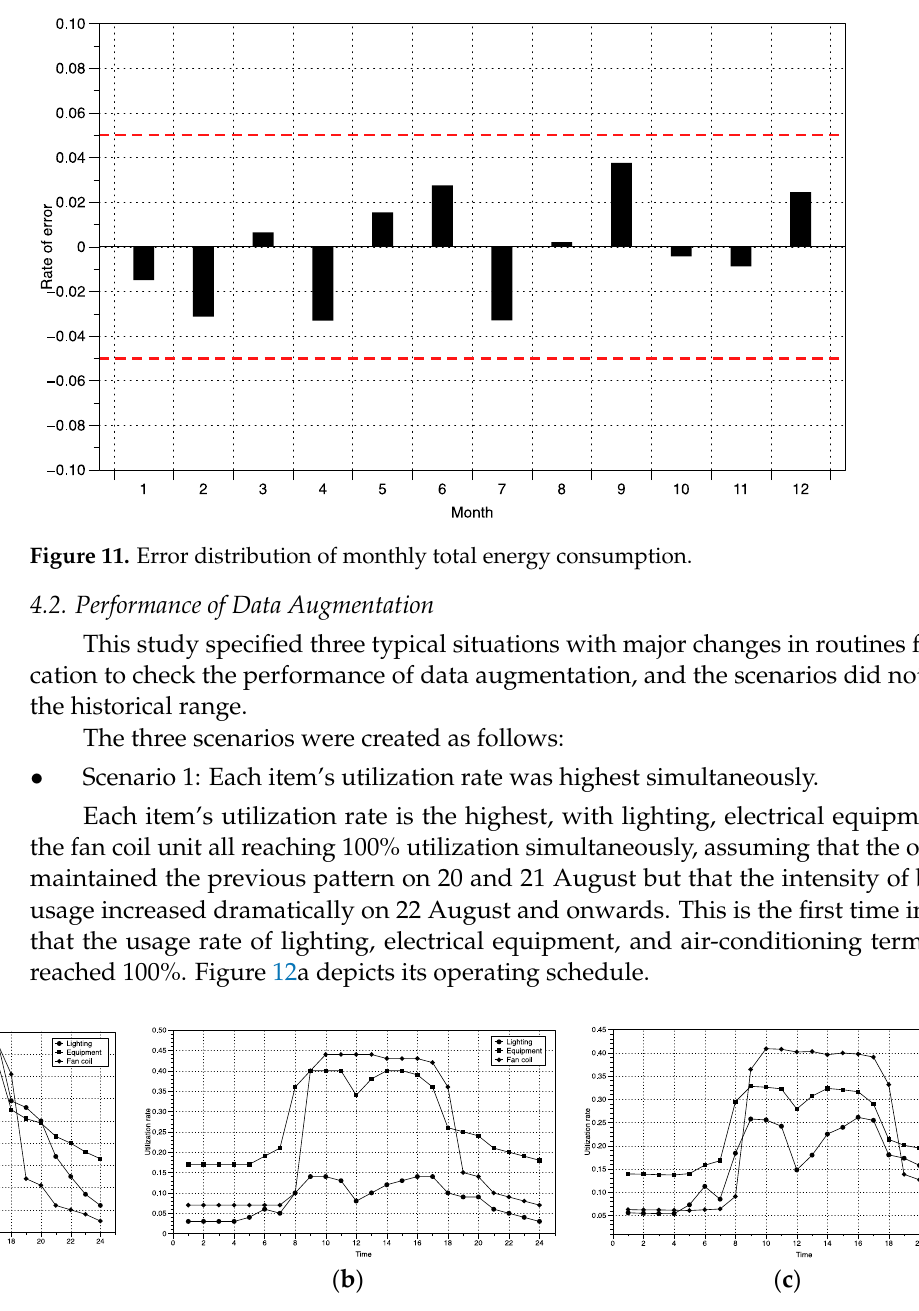
Figure 10. Comparison of calibrated simulated energy consumption with measured data.